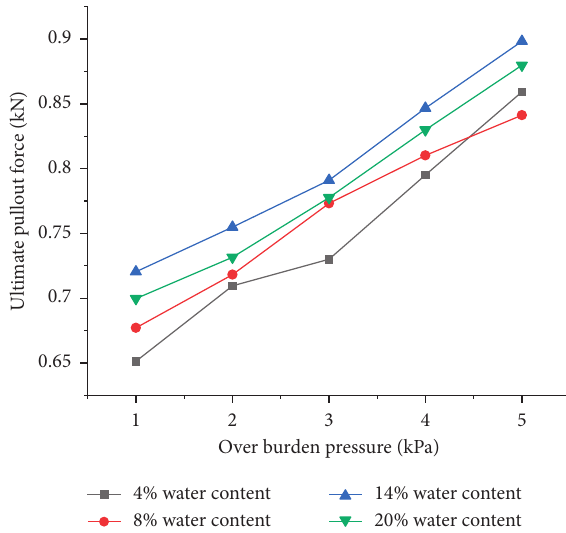
Figure 7: The ultimate pullout force-overburden pressure curve with different water content for 30 dry-wet